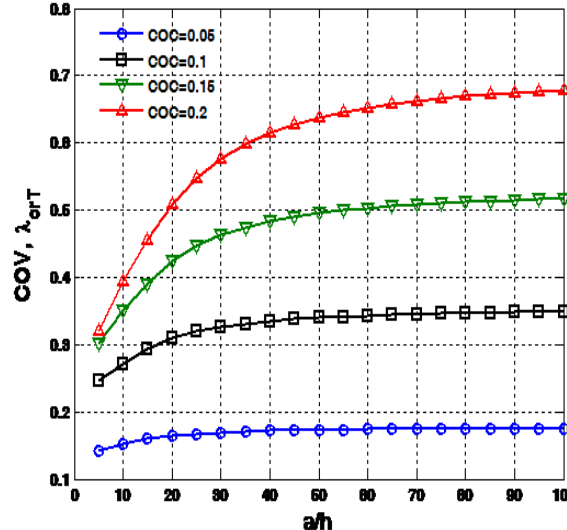
Figure 12: Effect of COV of random change in system properties and plate thickness ratios with random change in system parameters on the COV of buckling